Question: What direction does the quantity move in — increasing or decreasing?
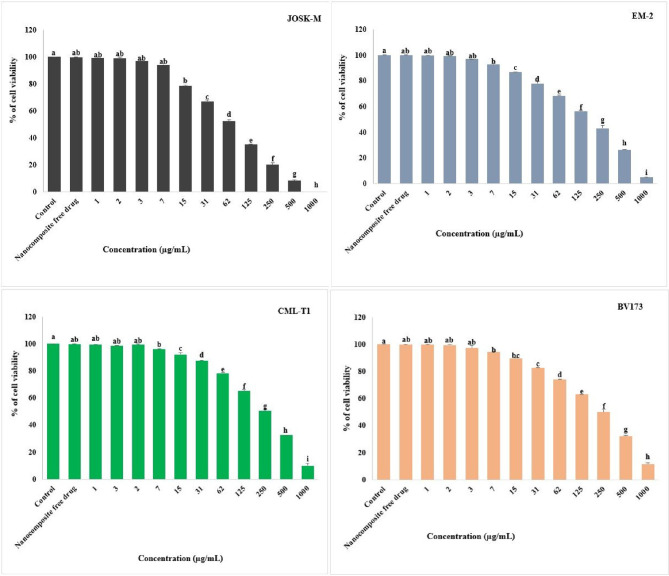
Answer: increasing